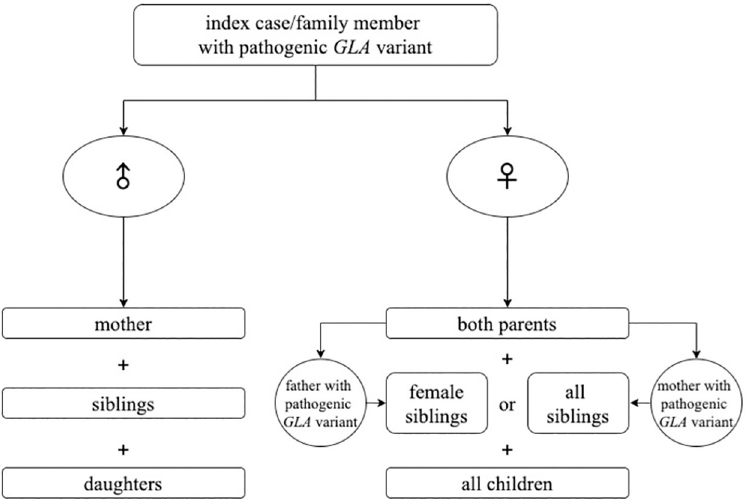
Fig 1. Flow chart of the principle of the procedure of the cascade screening. Cascade screening begins once an index-case has been identified. Three generations surrounding the index-case are genetically screened. Each time a family member with a pathogenic GLA variant is identified, the procedure is repeated. When the index-case/family member with a pathogenic GLA variant was male, his mother, his daughter and all his siblings were offered testing. When the index-case/family member with a pathogenic GLA variant was female, both her parents, and all her children were offered testing and depending on the parents’ result, either only her female siblings in case of a father with pathogenic GLA variant or all her siblings in case of a mother with pathogenic GLA variant were tested ( ♂ = male, ♀ = female).